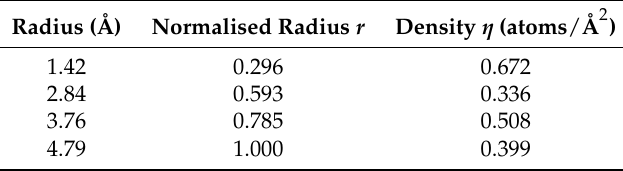
Table 2. Atomic density values at particular radii